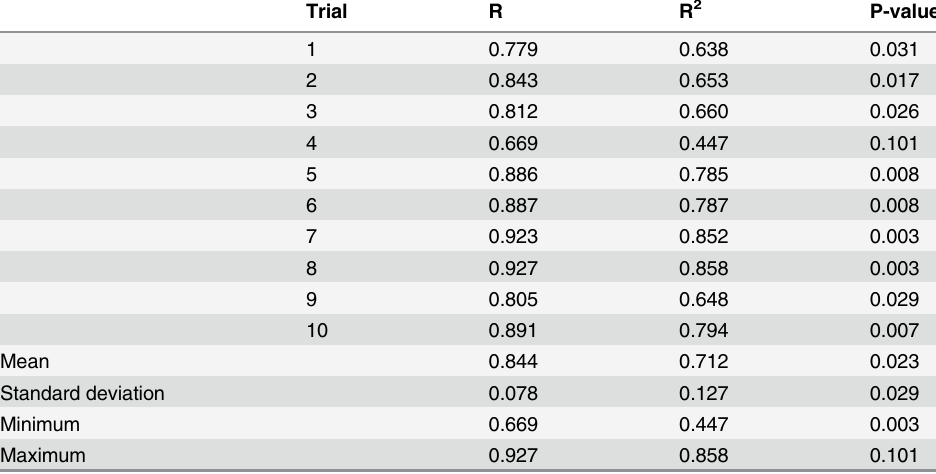
Table 4. Recorded abundance of Gopherus flavomarginatus expressed as the number of burrows/ Km 2 .